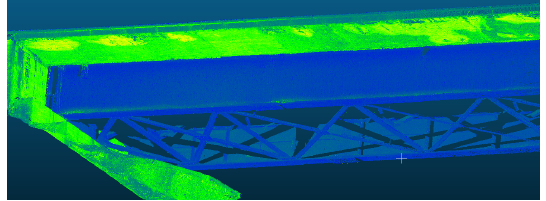
Figure 6: Cloud points of a portion of the road bridge of Fig. 5.